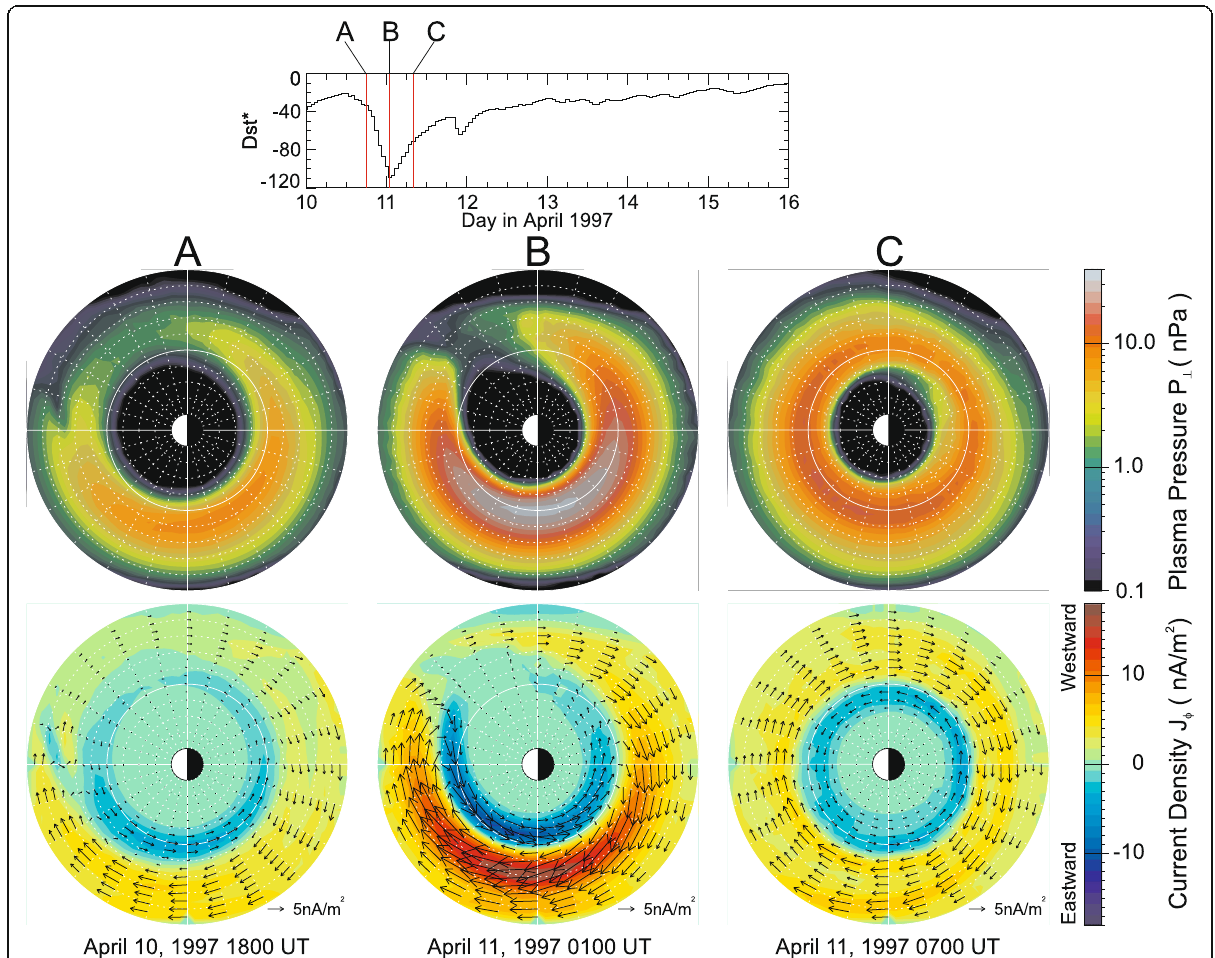
Fig. 2 Calculated ring current during the moderate storm of 10 – 12 April 1997. Perpendicular component of the plasma pressure ( P ⊥ ) and the azimuthal component of the current density are provided. (Ebihara and Ejiri